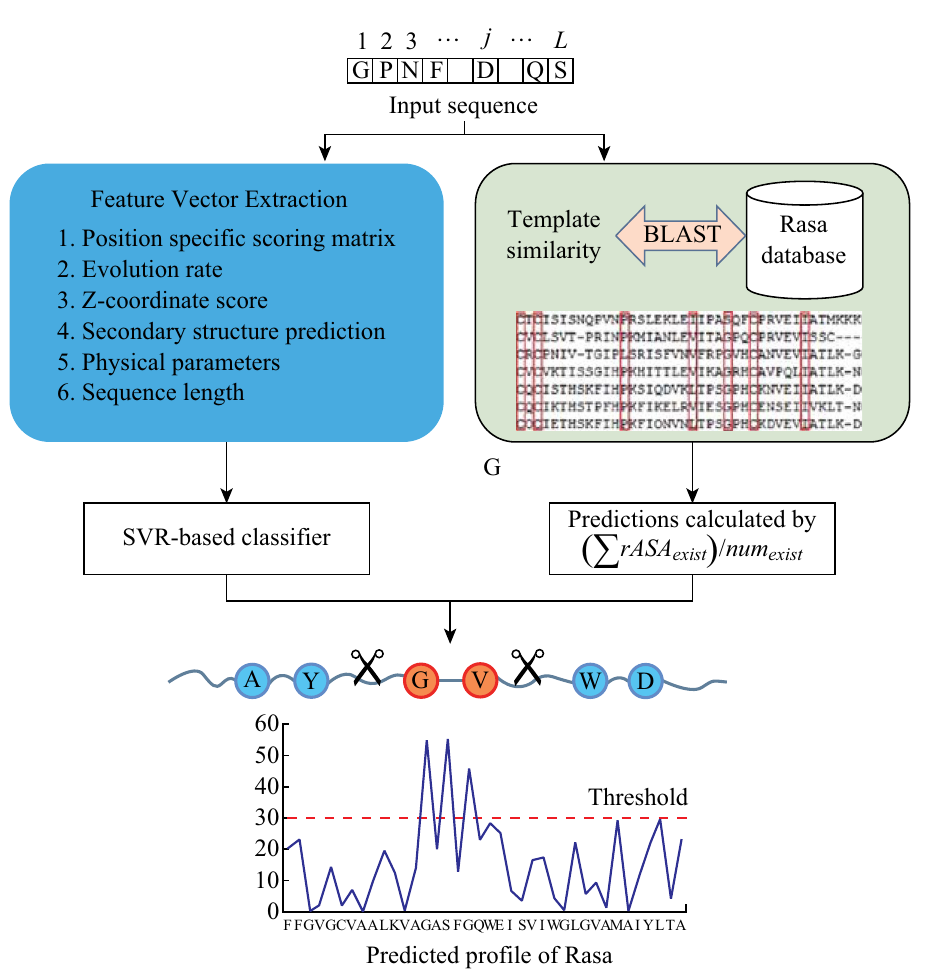
Fig. 5 The flowchart of MemBrain-Rasa prediction protocol. For a protein sequence, we extract six kinds of sequential features, which will be fed into the SVR classifier. We also designed a segment template similarity-based prediction engine for searching similar segments as templates for the target sequence against a locally constructed structure data pool. The outputs of the two engines are combined together to improve the prediction of relative accessible surface